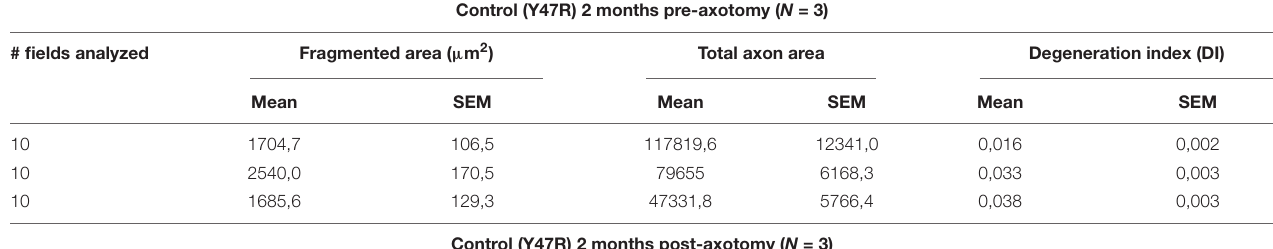
TABLE 3 | Data obtained for the quantification of the degeneration index of the control mice.